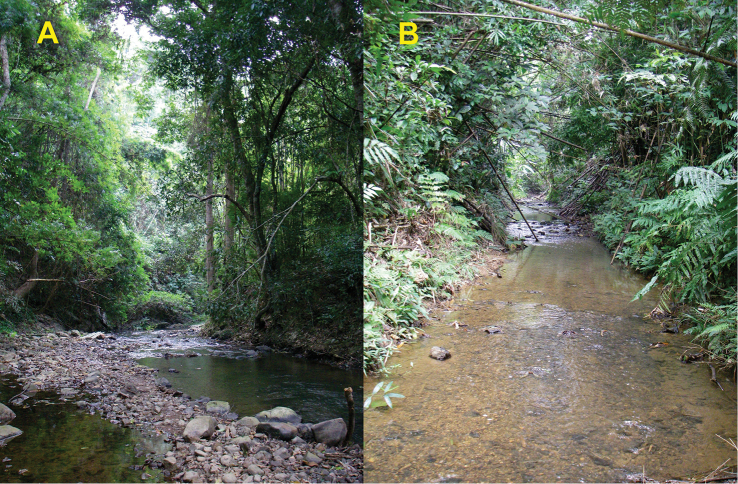
Habitat of Limnonectessavan sp. nov. in Savannakhet Province, Vilabouli District, Laos in December 2008 at A Houay Khalai Stream, Ban Khalai Village, and B Houay Hong Stream, Ban Houay Hong Village.